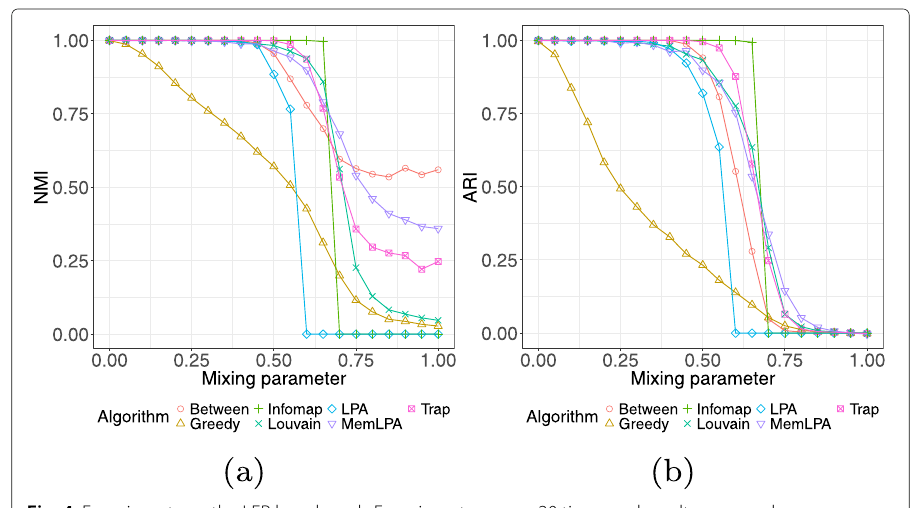
Fig. 4 Experiments on the LFR benchmark. Experiments are run 20 times and results averaged